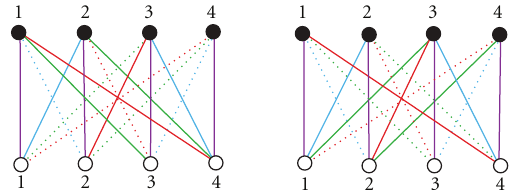
Figure 1: The two N (cid:7) 4 Valise Adinkras. The Adinkra on the right is obtained from the Adinkra on the left by implementing a “twist”, toggling the parity of the green